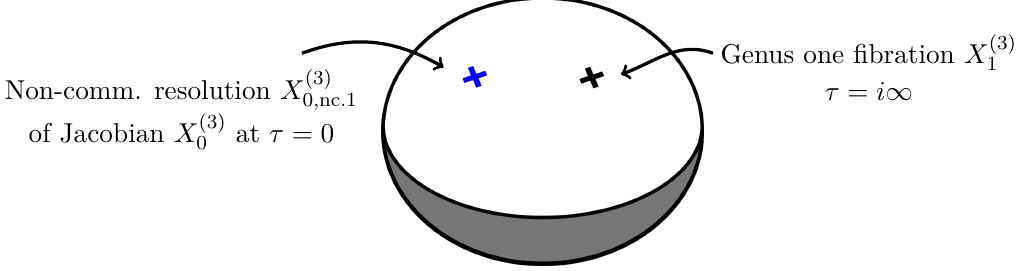
Figure 3 . The stringy Kähler moduli space of generic genus one curves of degree 3 is the modular curve X (3) . For Calabi-Yau fibrations with 3 -sections, the large volume points in the Γ 1 τ = 0 correspond to the non-commutative resolution of the